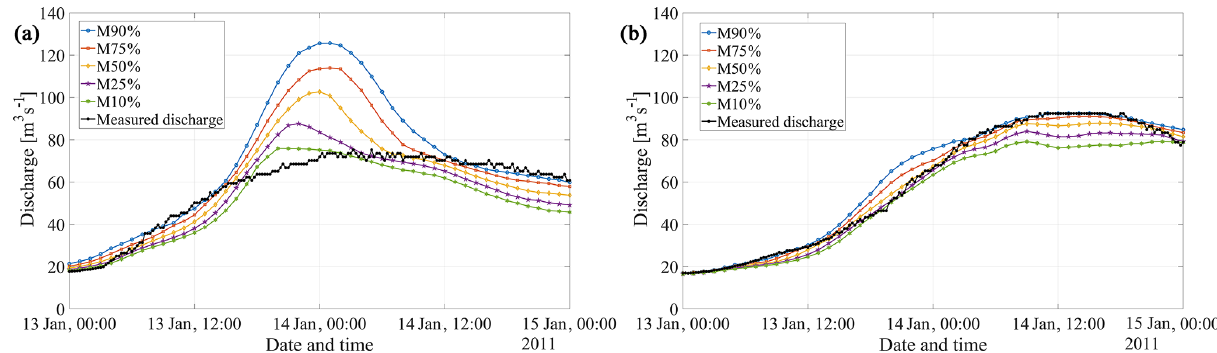
Figure 3. Hindcasted flood event of January 2011: measured discharge hydrograph along with 10%, 25%, 50%, 75% and 90% percentile discharges for gauges (a) Ködnitz and (b) Kauerndorf (discharge data based on Beg et al., 2018; measured discharge from Bavarian Hydro- logical Services, http://www.gkd.bayern.de, last access: 5 March 2018).